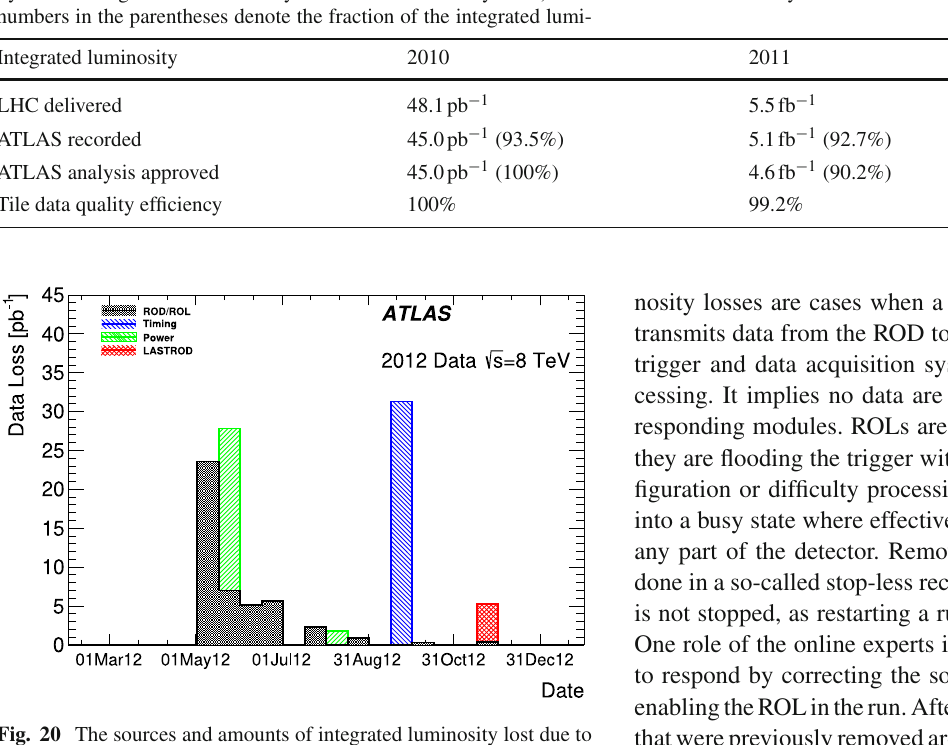
nosity relative to the entry on the previous line. The last row lists the fraction of the ATLAS recorded data approved as good quality by the